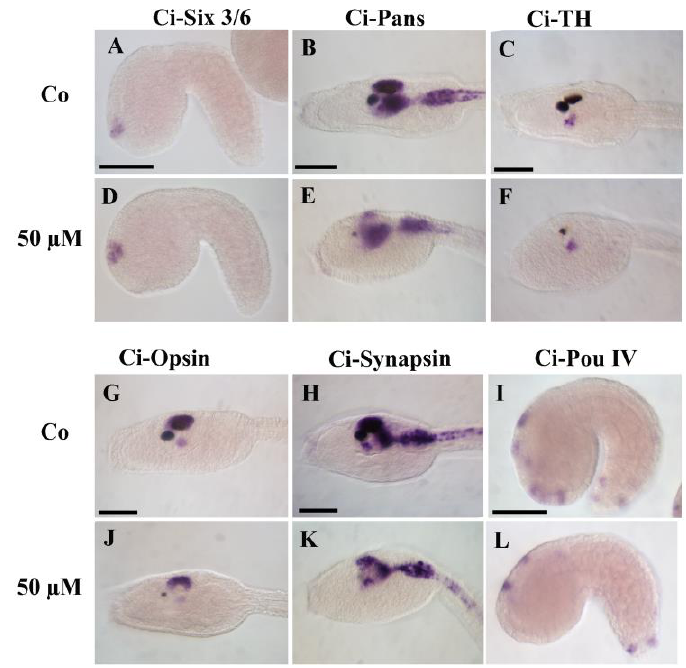
Figure 5. Effects of WAY-100635 on neural differentiation. Expression pattern of neural markers in mid-tailbud embryos ( Ci-Six 3/6 : ( A , D ); Ci-Pou IV : ( I , L )) and larvae ( Ci-Pans : ( B , E ); Ci-TH : ( C , F ); Ci-Opsin : ( G , J ); and Ci-Synapsin : ( H , K )) of C. intestinalis . Scale bars: 50 µm.